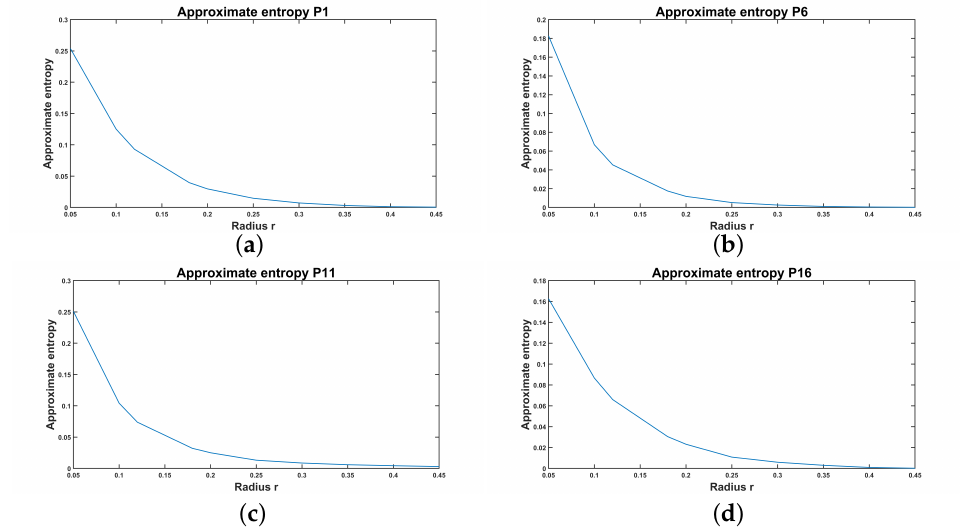
Figure 9. AppEn for several signals from the RC dataset. ( a ) ApEn for a signal from the class P1, ( b ) ApEn for a signal from the class P6, ( c ) ApEn for a signal from the class P11, ( d ) ApEn for a signal from the class